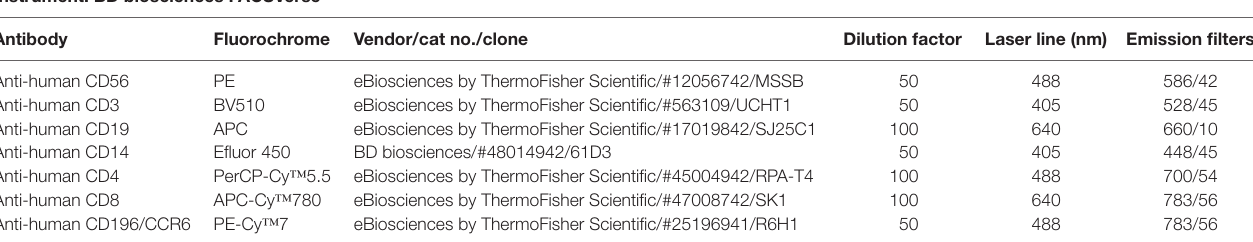
TaBle 1 | Reagent list used for flow cytometry experiments. instrument: BD biosciences FacsVerse ™ antibody Fluorochrome Vendor/cat